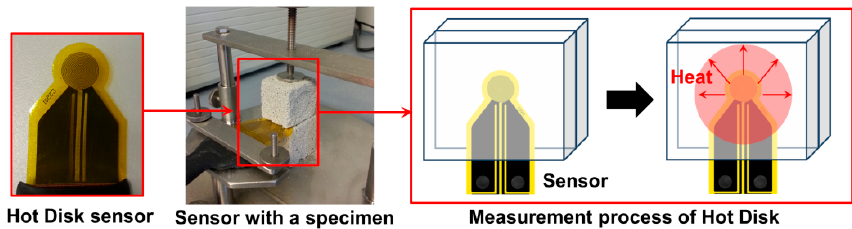
Figure 3. Schematic set-up for measuring thermal conductivity [20].